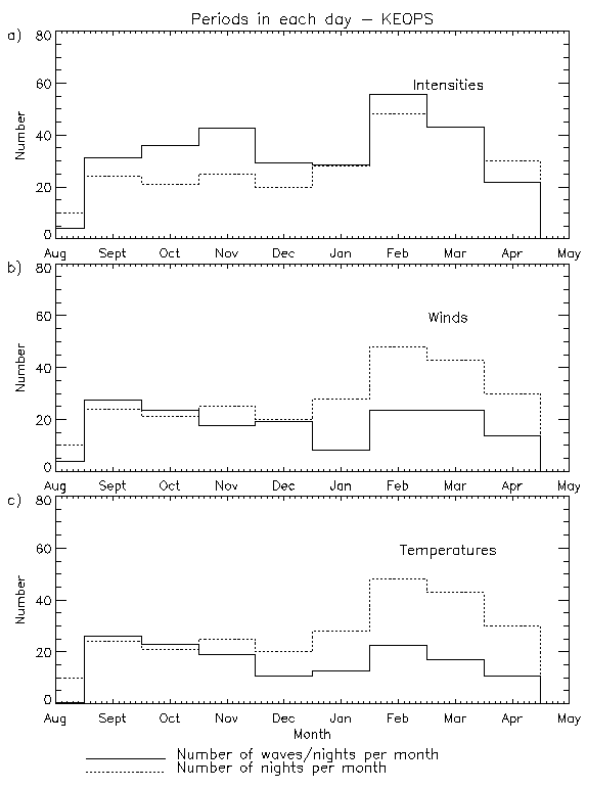
Fig. 16. Number of gravity waves with periods 0–4h detected in each month as a proportion of the number nights of data, for all KEOPS data (2000–2006): (a) intensities, (b) winds, and (c) tem- peratures.